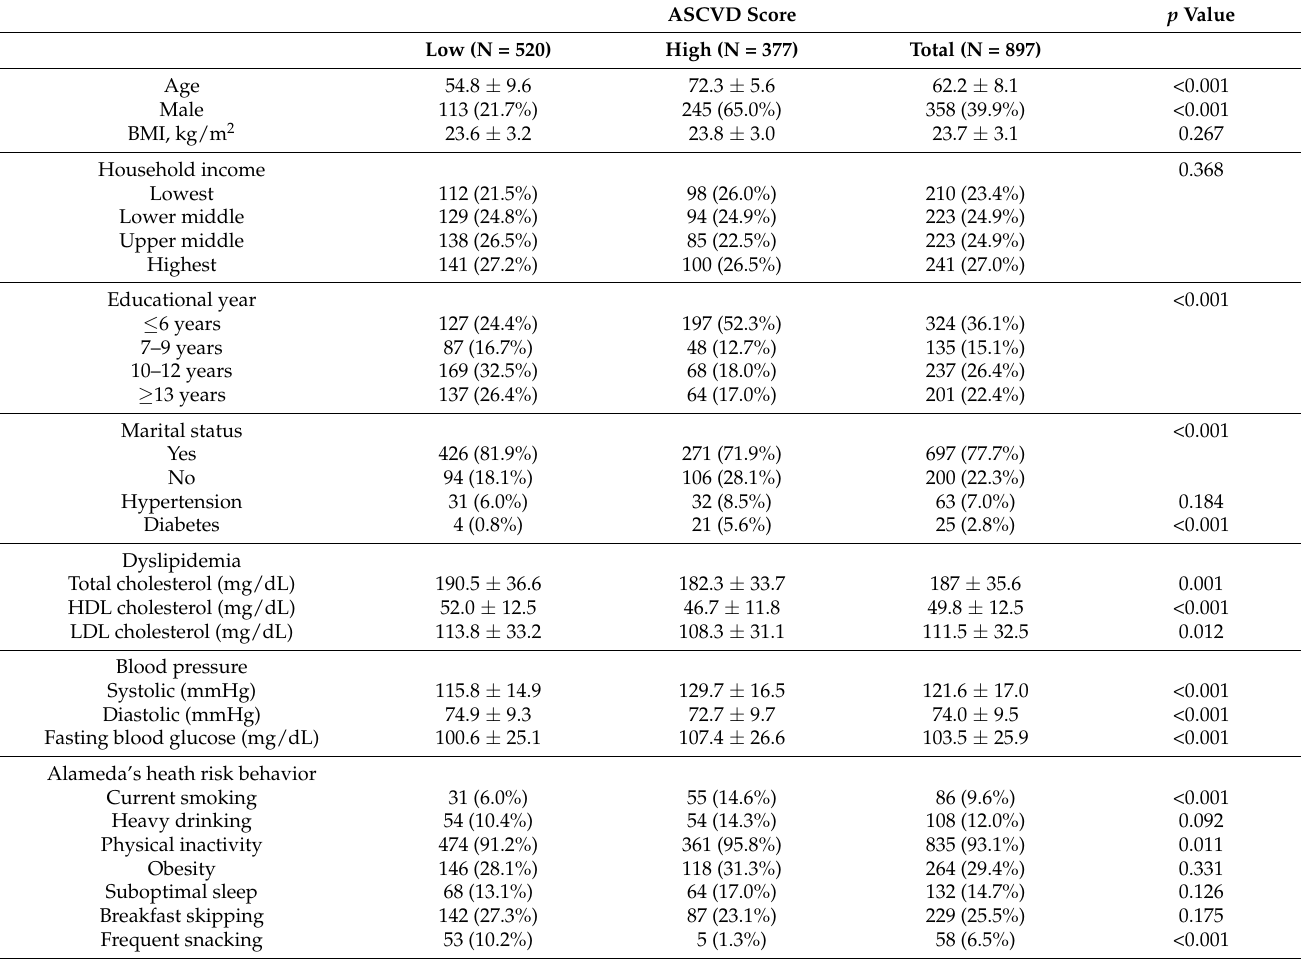
Table 1. Comparison of baseline characteristics between low and high ASCVD score in cancer